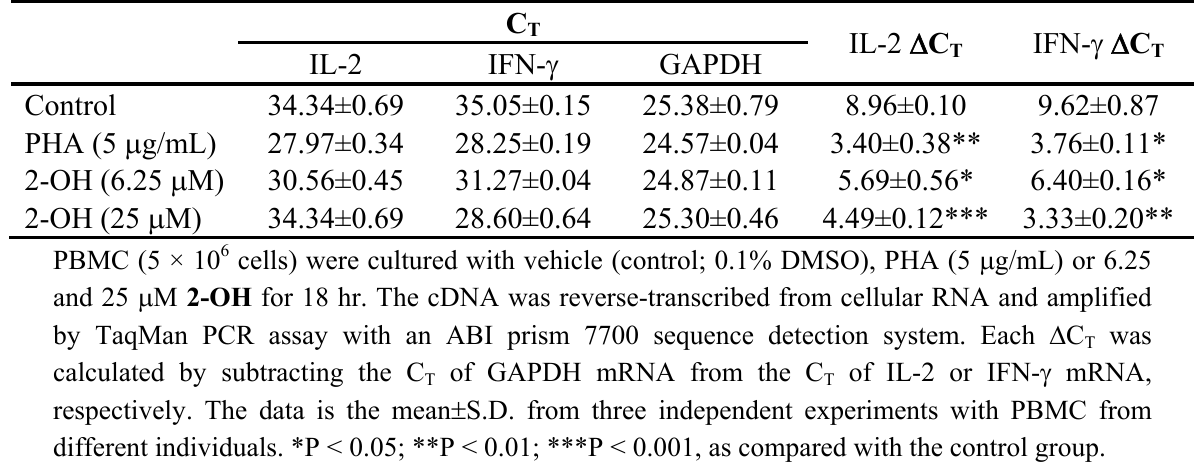
Table 2. Δ C for IL-2 and IFN- γ  at 2-OH-treated T